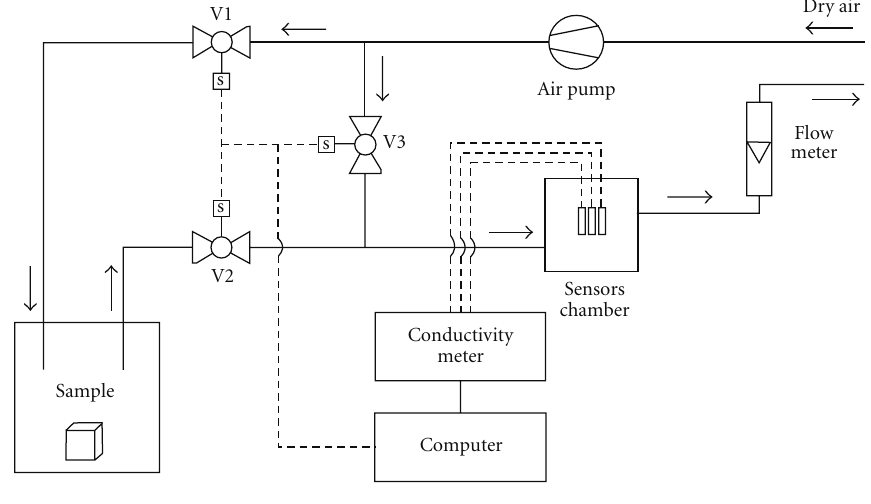
Figure 3: Setup of the e-nose measuring